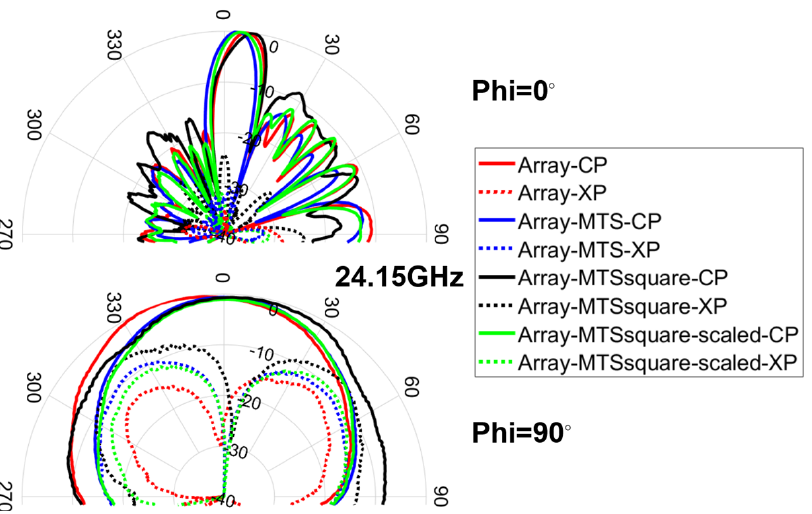
Figure 10. Measurement results for the co-polar (CP) and cross-polar (XP) radiation pattern compo- nents of the antennas under analysis for Phi = 0° and Phi = 90° cuts at 24.15 GHz.